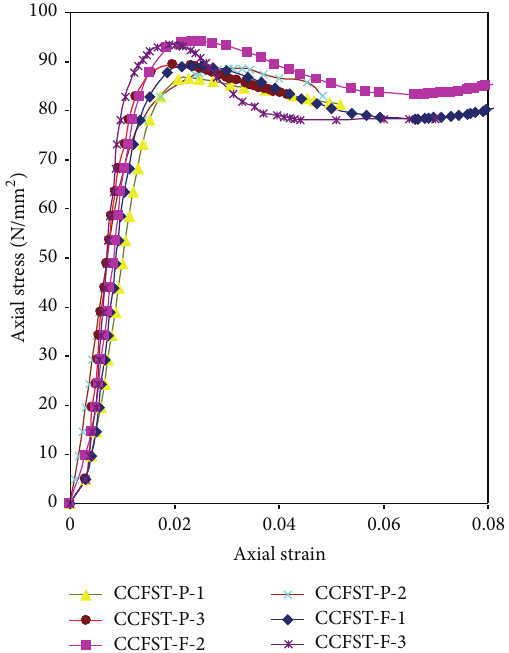
Figure 8: Axial stress-strain behavior of square CFST column subjected to full and partial